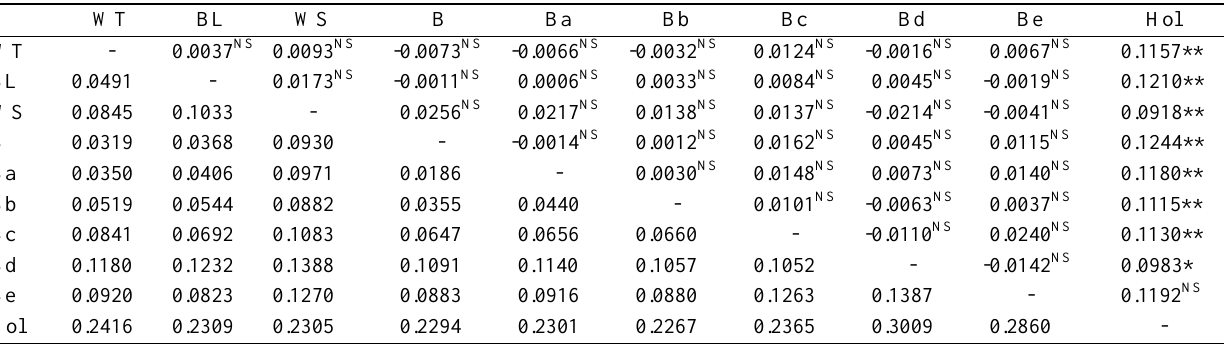
Table 4. D A genetic distances (lower) and population differences ( F st , upper) among Hanwoo cattle grouped according to phenotypic characteristics